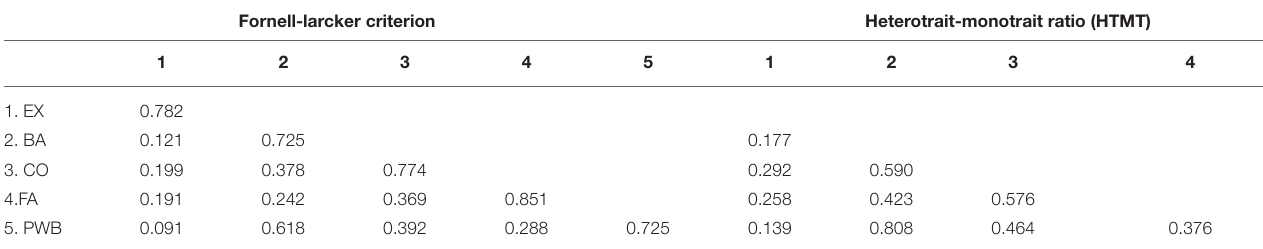
TABLE 3 | Measurement model: discriminant validity. Fornell-larcker criterion